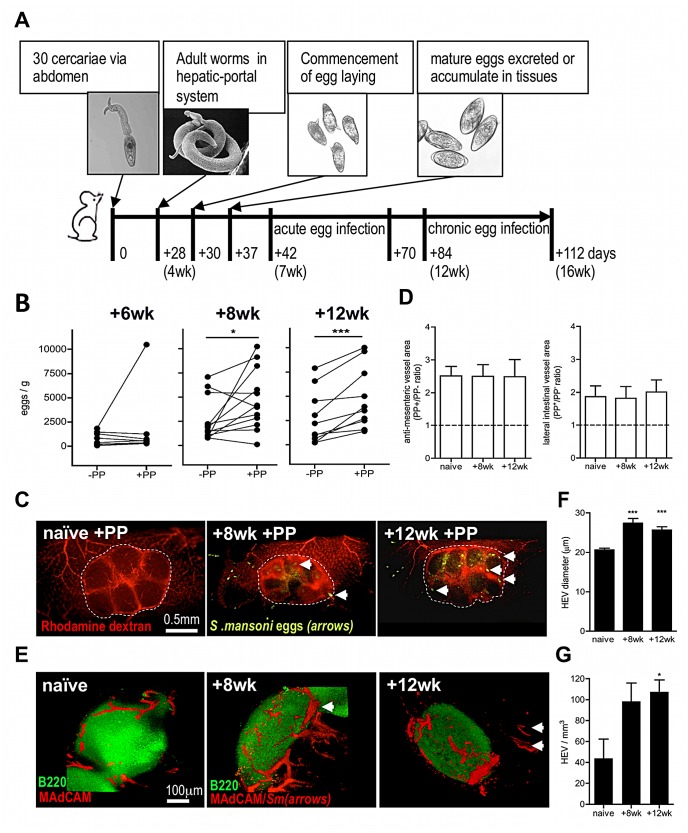
Egg deposition is more abundant within PP-associated vasculature.(A) Outline of experimental S. mansoni infection. (B) Numbers of eggs/g intestinal segments containing PP (+PP), or adjacent segments lacking PP (−PP) at 6, 8, and 12 weeks post-infection (pi). Data for −PP and +PP gut samples from the same mouse shown by connecting lines, n = 10–12, *P<0.05 or ***P<0.001, paired T test. (C) Angiograms of +PP vasculature (rhodamine dextran; red) in naïve mice, or 8 and 12 weeks pi. Dotted line demarks PP; arrows indicate schistosome eggs (auto-fluorescence). (D) Ratio of vascular area in PP+/PP− gut (imaged at the anti-mesenteric serosal face or 90° lateral to the anti-mesenteric face) based on angiograms in naïve mice or 8 and 12 weeks pi; min 3 PP/mouse. (E) 3D confocal images of PP stained for B cell follicles (green B220+) and HEV (red MAdCAM+); Arrows = schistosome eggs (auto-fluorescence). (F & G) Quantification of HEV from 3D rendered confocal images of gut sections stained for MAdCAM+ (red), ***P<0.001, *P<0.05 cf. naïve, 1-way ANOVA with Tukey's post-hoc. Data is mean (+SEM), n = 3–4 mice/group and is representative of 2–3 independent experiments.